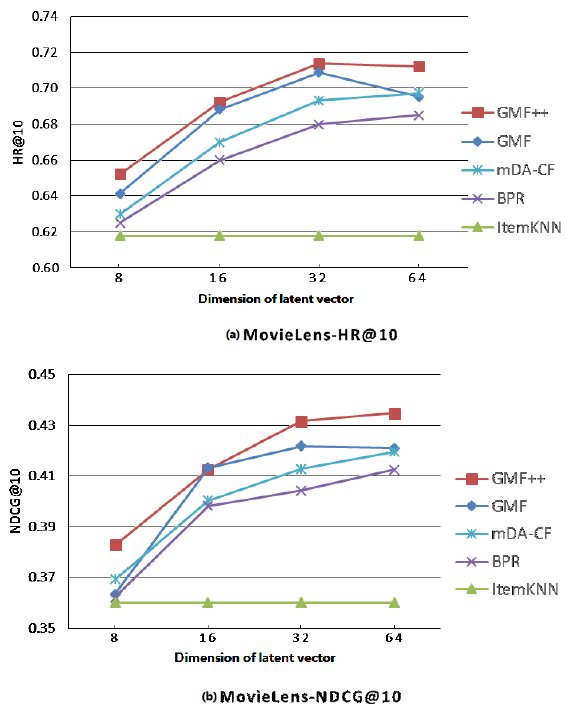
Fig. 3 Performances of HR@10 and NDCG@10 w.r.t. the dimension of latent